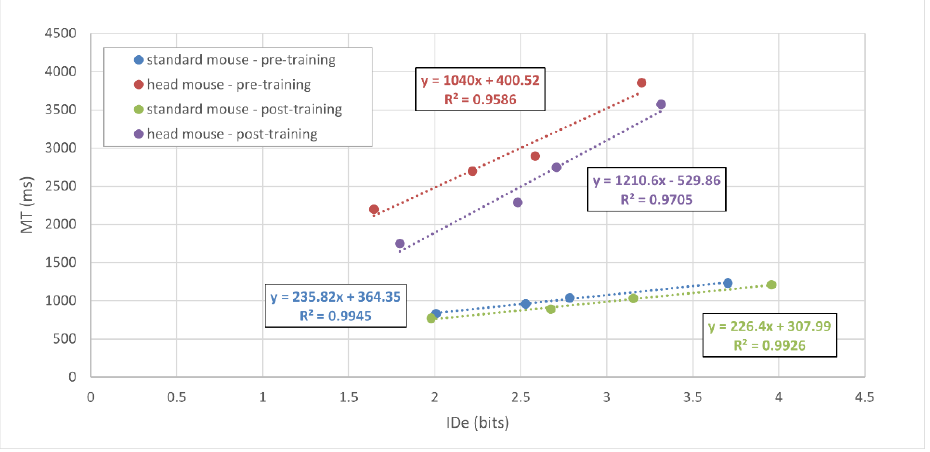
Figure 2. MT versus ID e for all subjects. The dotted lines show the best fits by the least squares’ method for each condition.